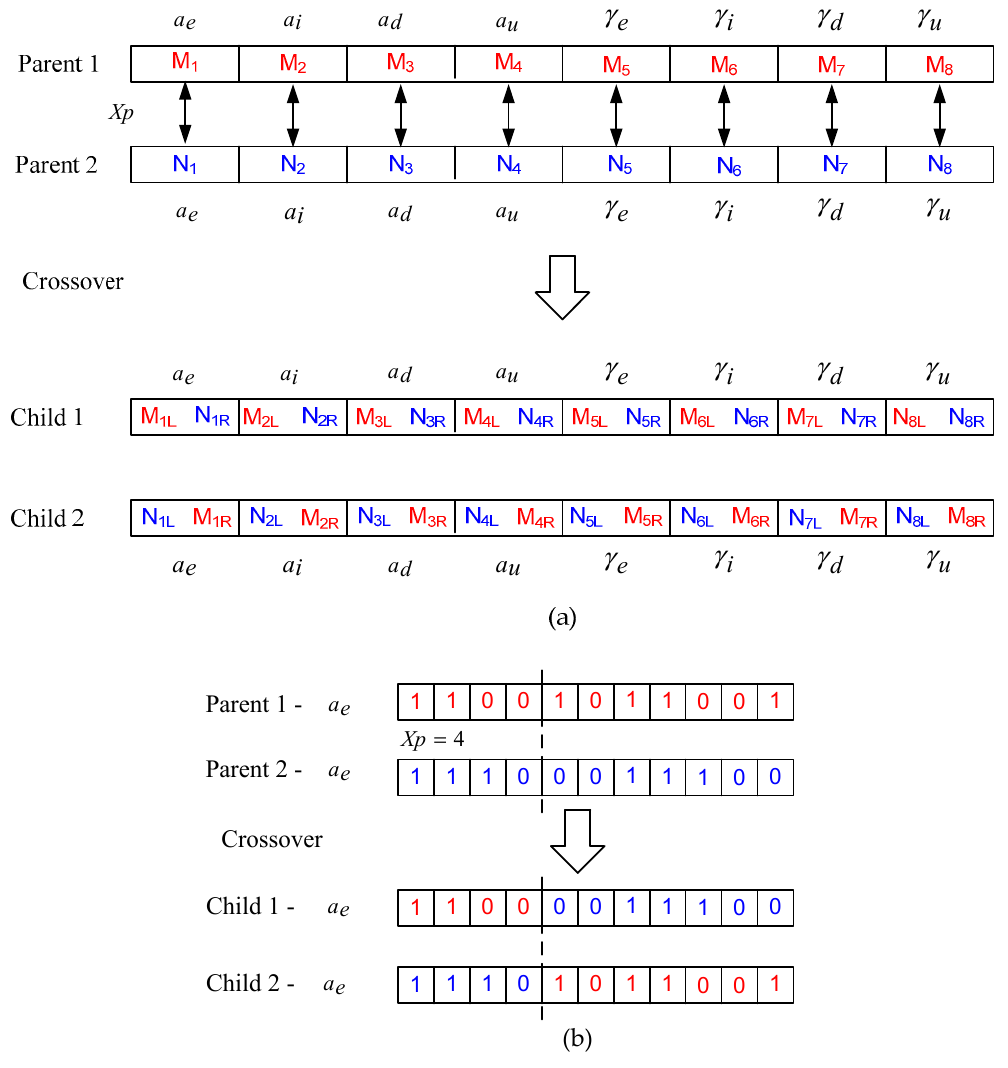
Figure 4. Crossover operation: ( a ) all parameters; and ( b ) single parameter.